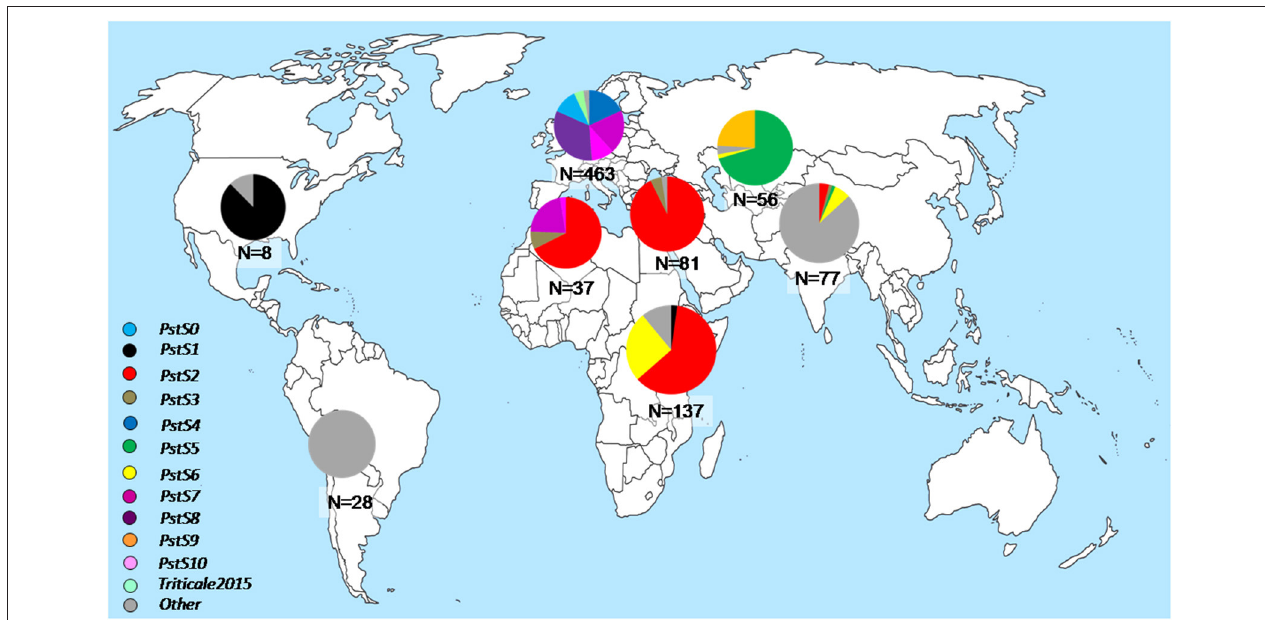
FIGURE 2 | Relative distribution of recently emerged P. striiformis races from divergent lineages across eight worldwide geographical regions during the period